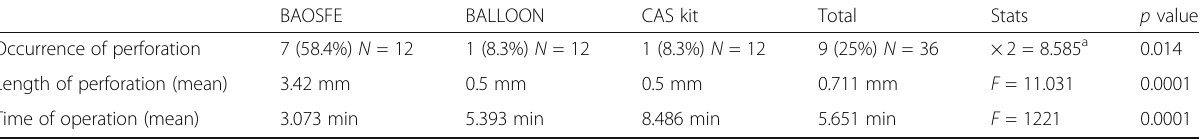
F ANOVA test a Chi-square